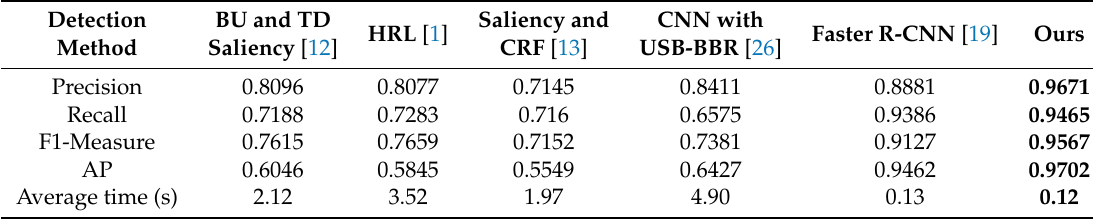
Figure 14. Detection results at different viewpoints. The true positives, false positives, and ground-truths are indicated by red, blue and green rectangles, respectively. ( a ) BU and TD saliency [12]. ( b ) Saliency and CRF [13]. ( c ) HRL [1]. ( d ) CNN with USB-BBR [26]. ( e ) Faster R-CNN [19]. ( f ) our network. Table 5. Comparison of the different airport detection